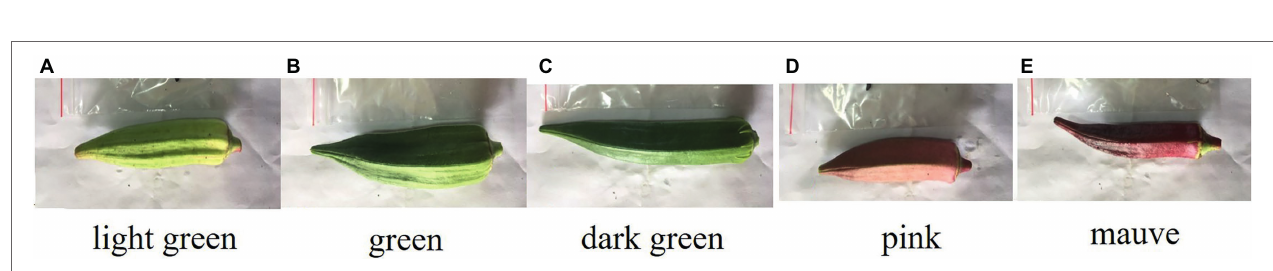
FIGURE 5 | Abelmoschus esculentus fruit colors. (A) . light green, (B) . green, (C) . dark green, (D) . pink, and (E) .